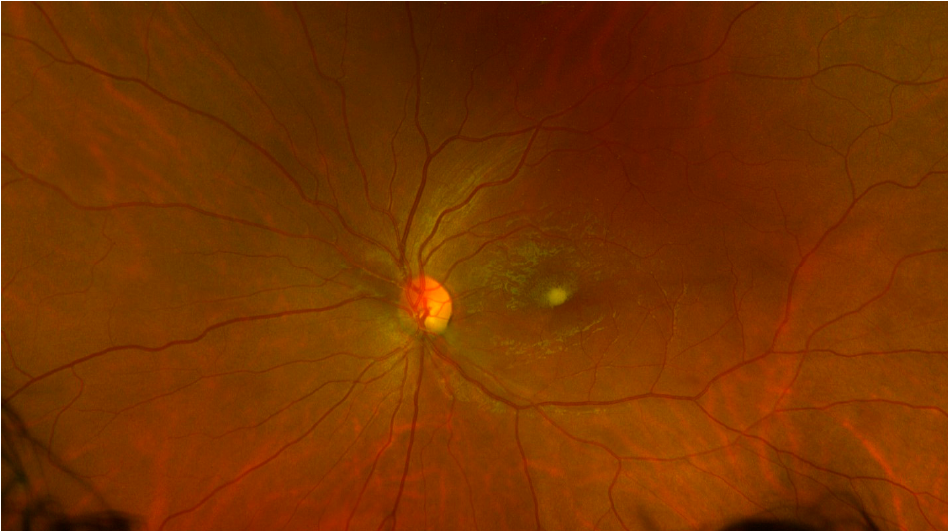
Figure 4. Color fundus photograph of the left eye at 7 weeks follow-up shows significant improve- ment of inferior retinal whitening and significant resorption of central macular hemorrhage. Note the yellowish superficial deposit over the fovea, consistent with residual dehemoglobinized blood. At 11-week follow-up, visual acuity in the left eye had returned to 20/20. Funduscopic exam was significant for complete resorption of blood and a residual wrinkly yellow sheen over the central macula. Humphrey visual fields remained stable. SD-OCT revealed a bridging membrane over the foveal depression. OCT-A (AngioVue; Optovue Inc., Fremont, CA, USA) was limited by artifact but suggested decreased retinal vascular bed density in the inferior macula (Figure